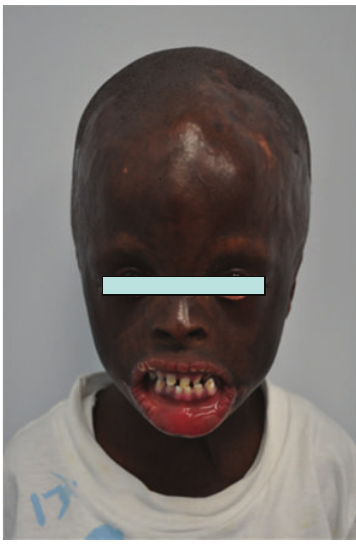
Figure 1: Marked craniofacial deformities.